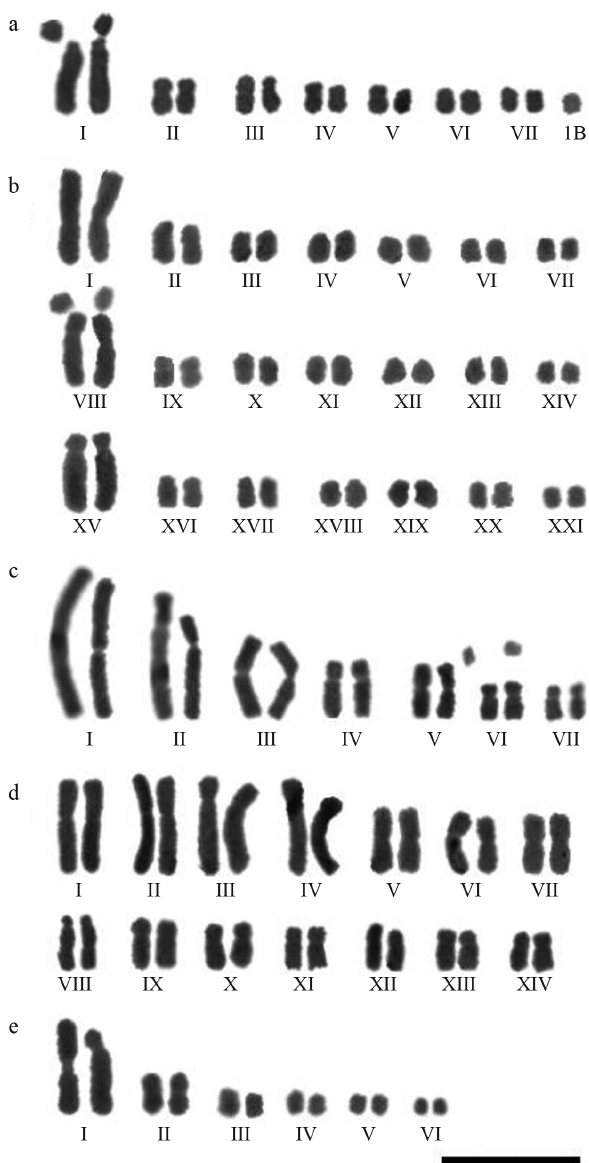
Figure 3 - Karyograms of some species of the Tribe Tigrideae from north- eastern Brazil. (a-b) Alophia drummondii : (a) 2 n = 14+1B and (b) 2 n = 42; (c) Cipura paludosa (2 n = 14); (d) C . xanthomelas (2 n = 28); (e) Eleutherine bulbosa (2 n = 12). The bar corresponds to 10 (cid:2)